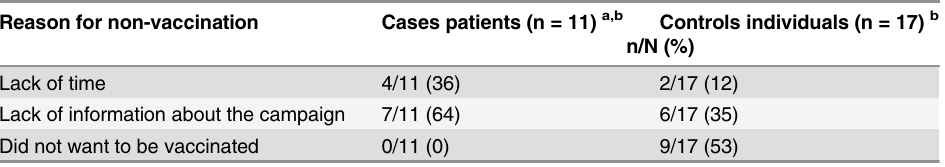
Table 5. Reported reasons for non-vaccination among case patients with illness onset after public MenC vaccination and matched individuals from affected neighborhoods. Reason for